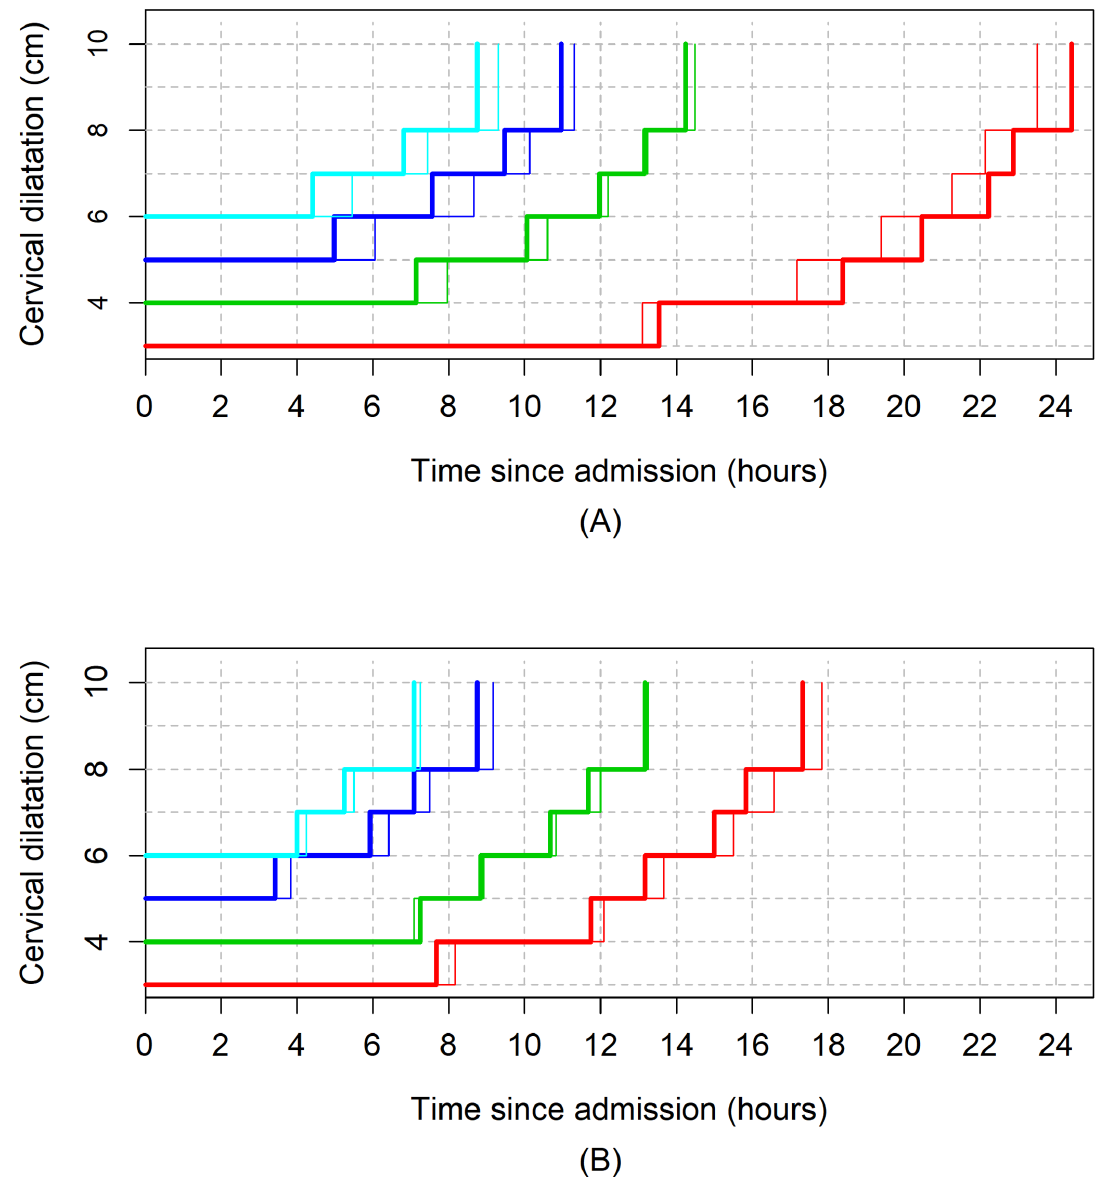
Fig 7. The 95th percentiles of cumulative duration of labour in nulliparous women by augmentation. (A) Survival analysis. (B) Multistate Markov analysis. Thin lines: all women. Thick lines: women with oxytocin augmentation excluded.